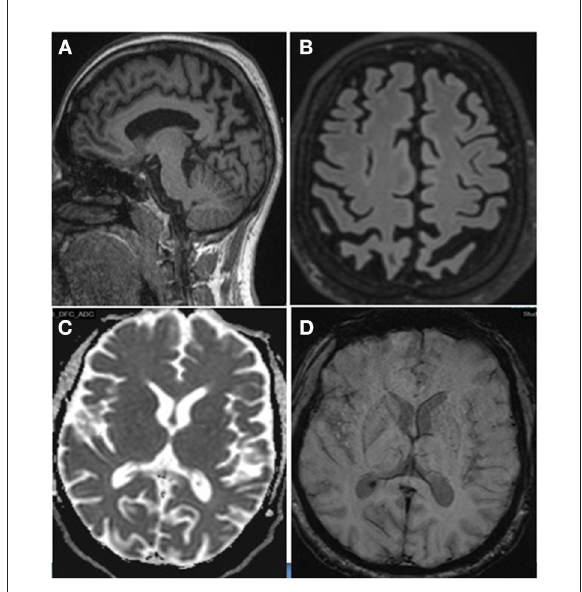
FIGURE2 Magnetic Resonance Imaging of the Brain-T1 MPR Sagittal (A) and T2 Flair coronal (B) image showing asymmetrical left predominant parietal lobe atrophy. Axial ADC (C) section showing no diffusion restrictions. Axial SWI (D) sections showing no areas of